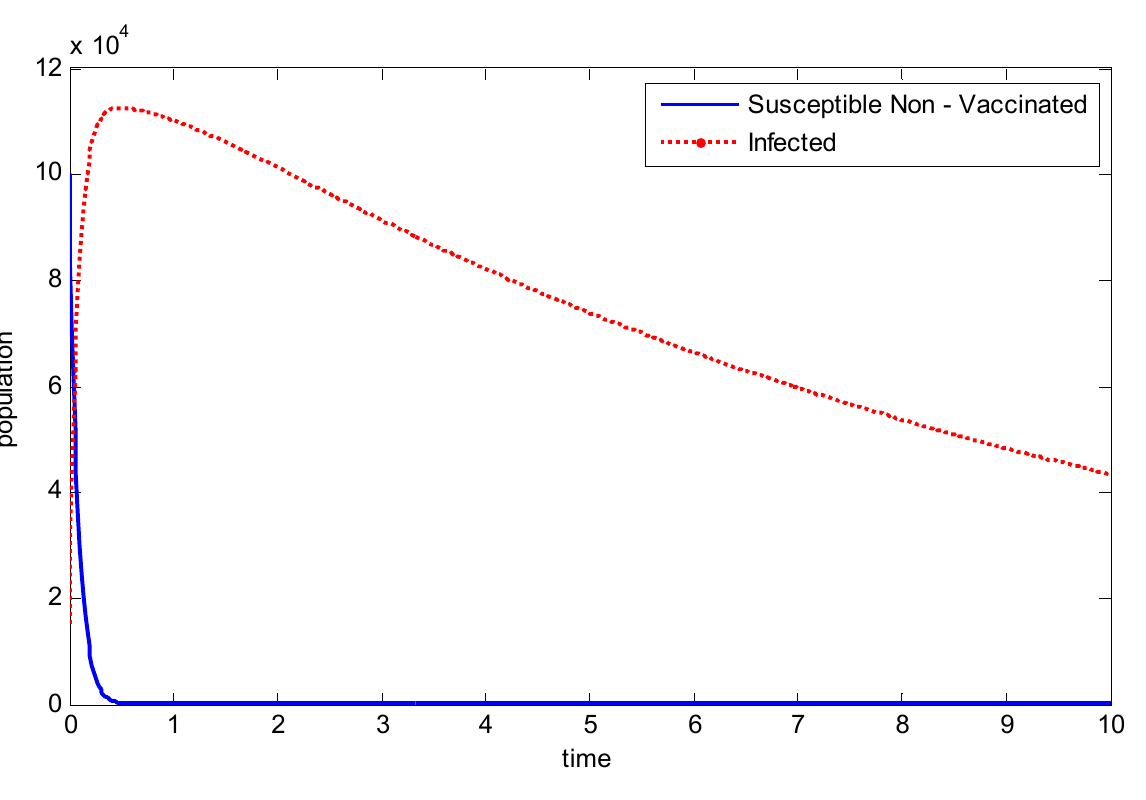
Figure 4. Comparing the susceptible non-vaccinated population with the exposed population.